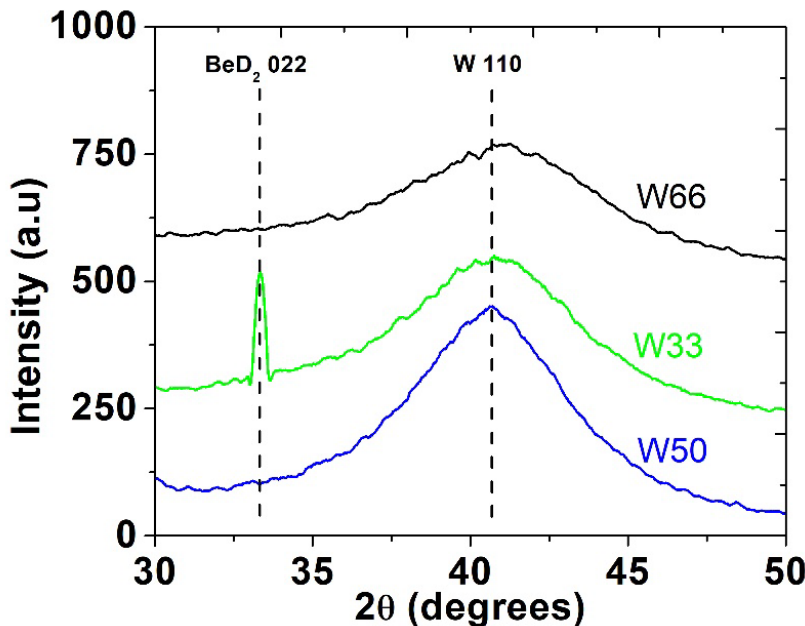
Figure 4. Overlapped diffraction patterns of the mixed Be-W layers.